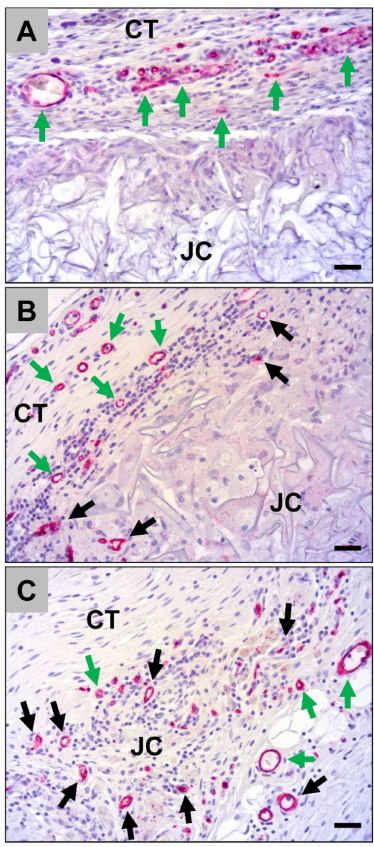
Figure 3. Representative histological images of the vascularization pattern of the jellyfish sca ff olds (JC) within the subcutaneous connective tissue (CT) at day 10 ( A ), day 30 ( B ), and day 60 post implantationem ( C ). Green arrows = vessels within the surrounding connective tissue, black arrows = vessels within the jellyfish collagen sca ff olds (CD31-immunostainings, 20 × magnifications, scalebars = 20 µ